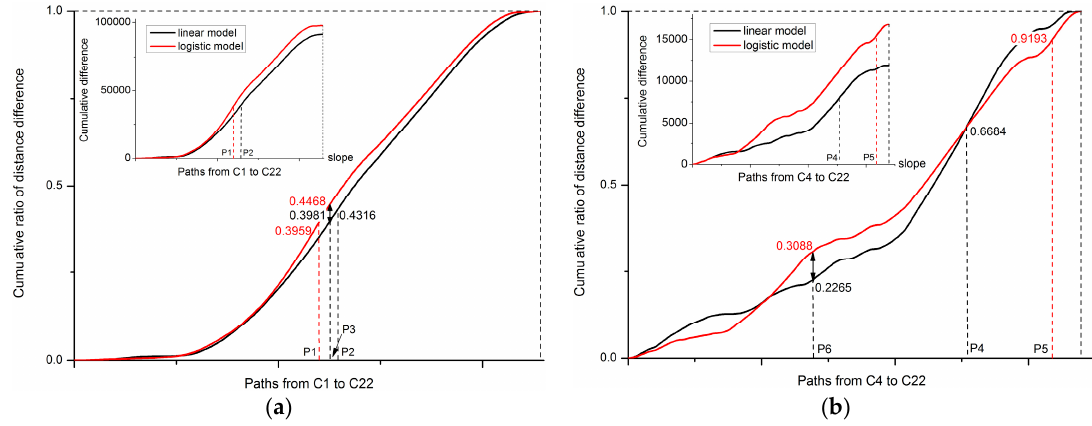
Figure 10. Cumulative deviation between defensibility models and slope model.